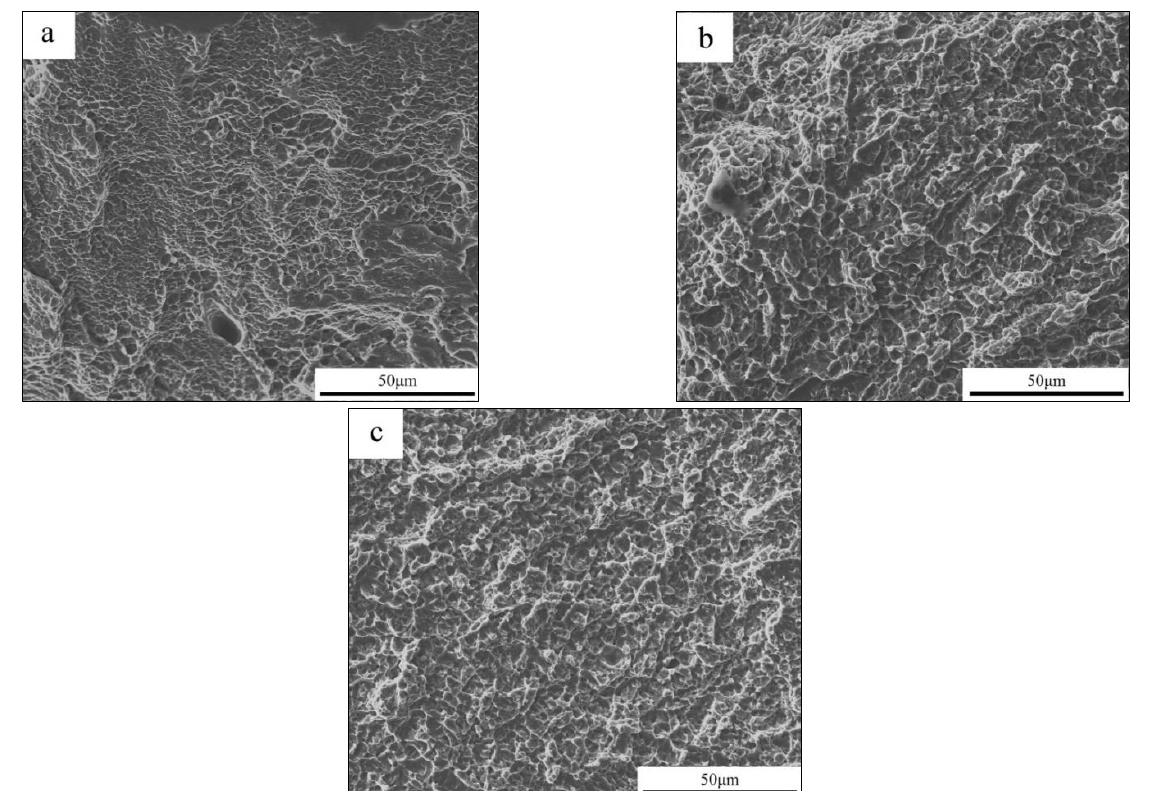
Figure 9. Fracture surfaces of the EBM Ti-6Al-4V alloys: as-built state( a ); after PIB ( N = 5) ( b ); after PIB ( N = 10) ( c ).